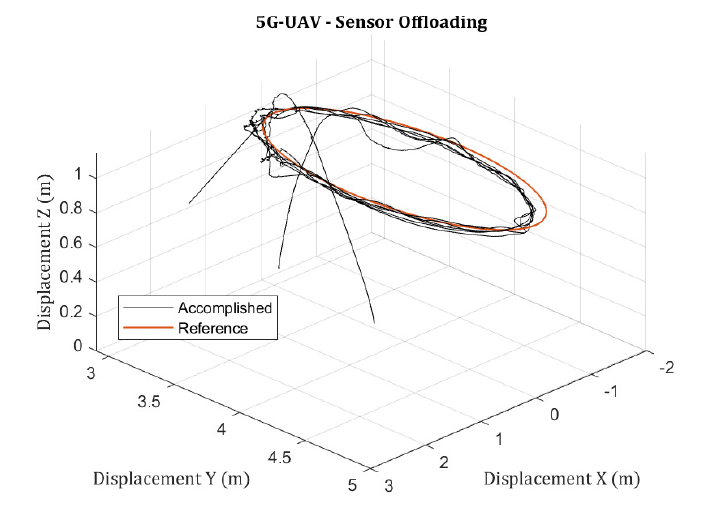
Figure 9. Trajectory of the 5G-UAV. Sensor offloading on the same 5G-UAV platform is turned on and off two